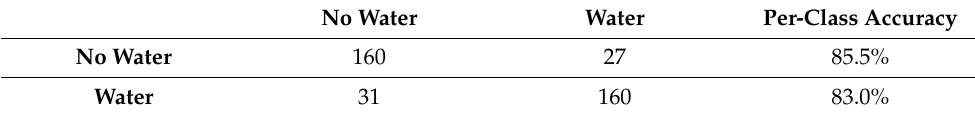
Table 9. Confusion matrix for the GoogleNet model onboard Nvidia Jetson